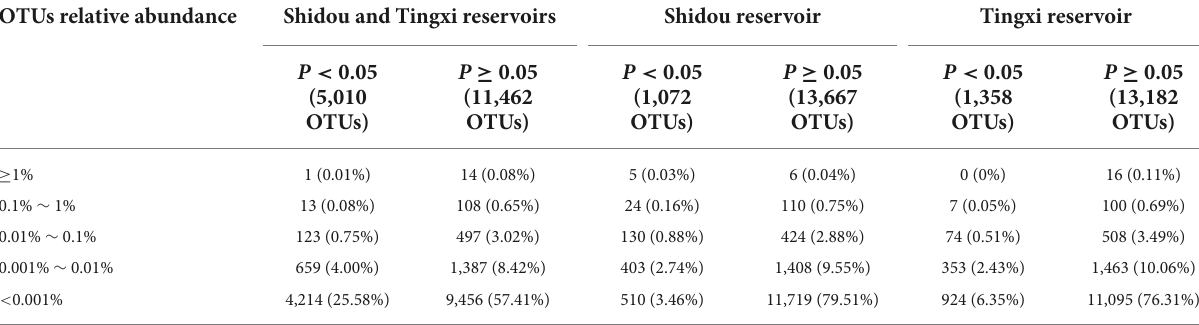
TABLE 1 The OTUs that are different ( P < 0.05) and non-significantly different ( P ≥ 0.05) between the 0.2–200 µ m and 0.2–3 and 3–200 µ m eukaryotic plankton communities in both reservoirs, Shidou Reservoir and Tingxi reservoir, respectively. OTUs relative